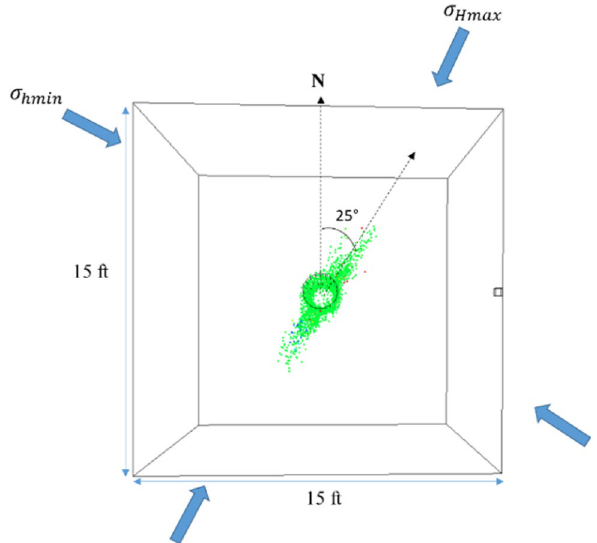
Fig. 22 Top view of fracture propagation (green dots) in the numeri- cal simulation with a single preexisting fracture (gray rectangular crossing the wellbore) with a strike of 25°. Shear and tensile fractures occur in the direction of the maximum horizontal stress